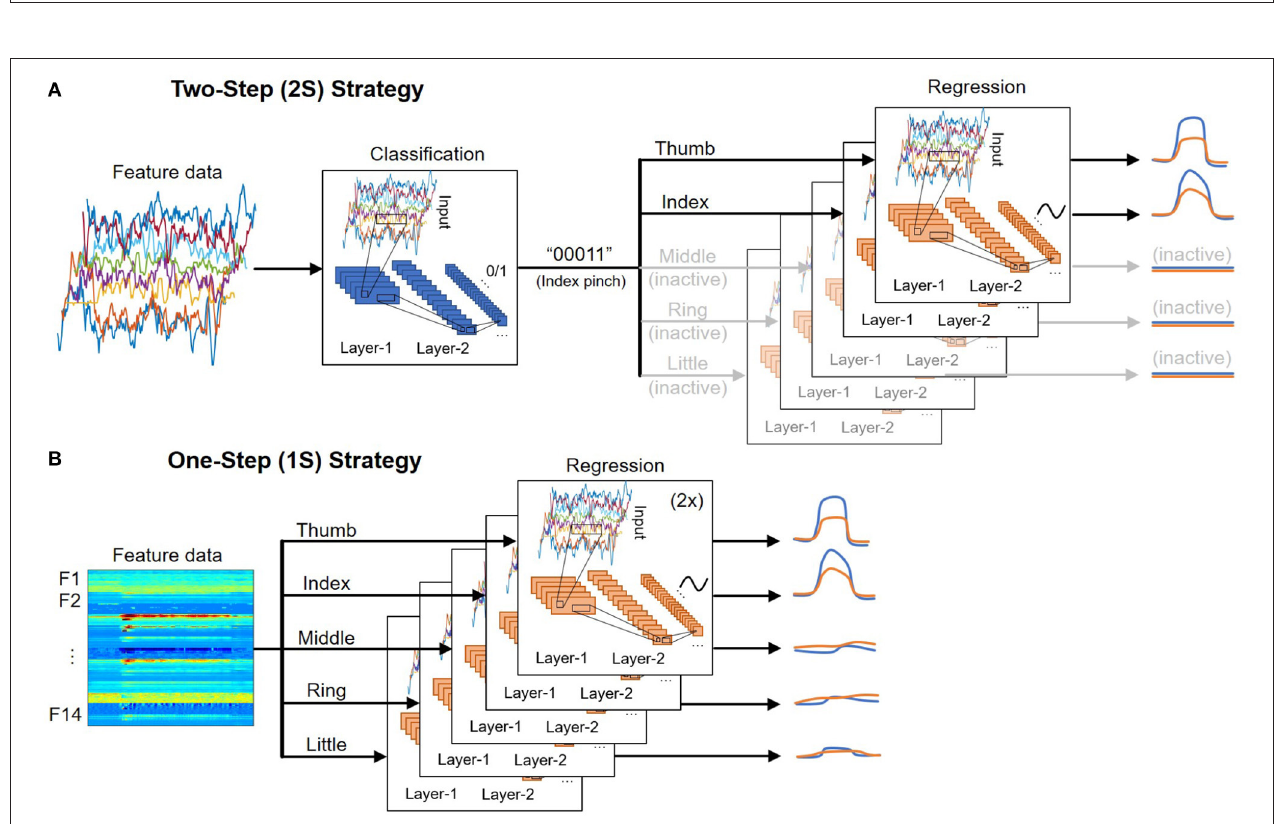
FIGURE 5 | Illustration of the (A) two-step (2S) and (B) one-step (1S) strategy for deploying deep learning models.